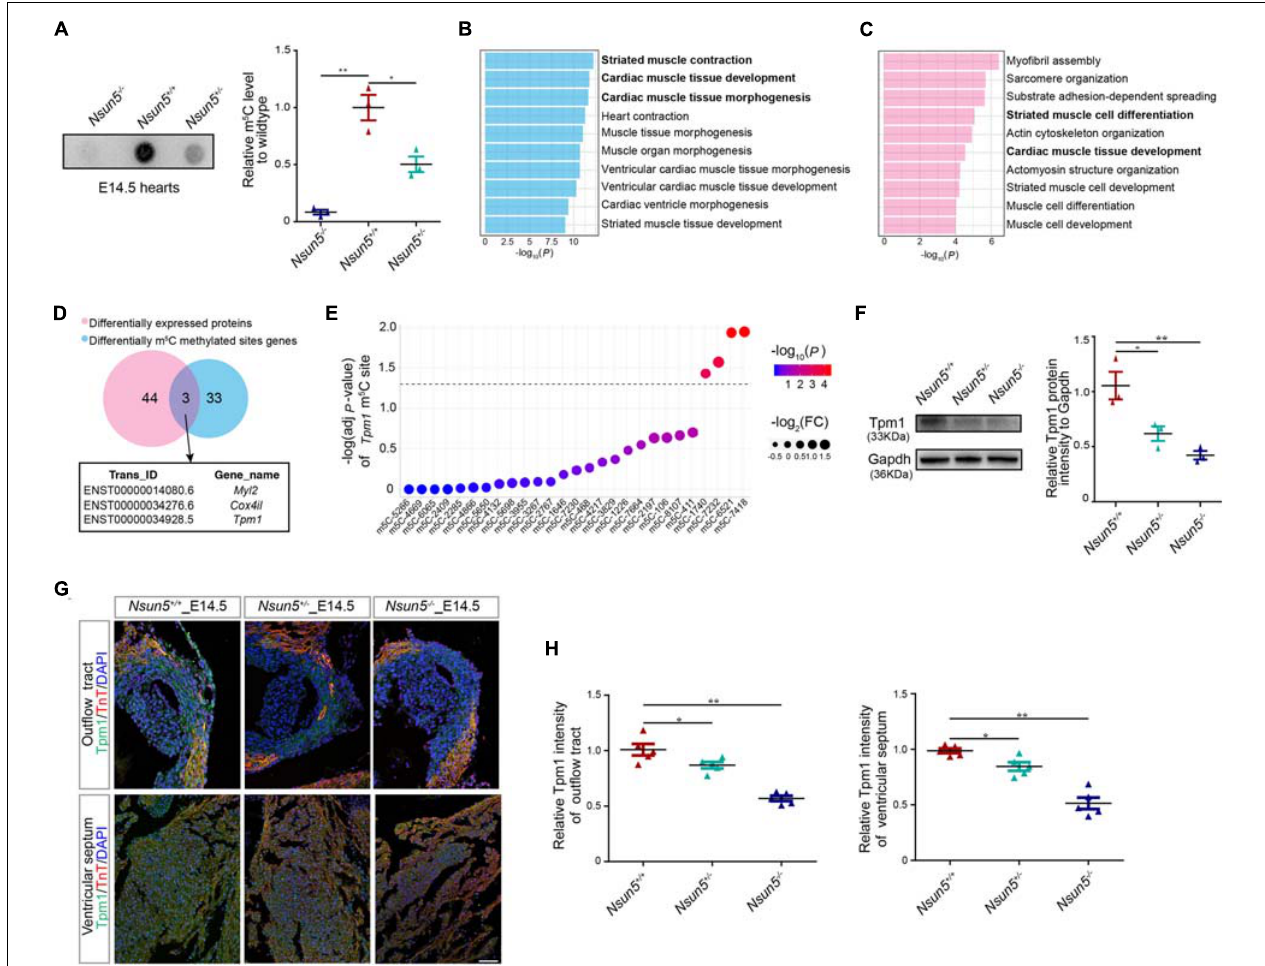
FIGURE 4 | Nsun5 regulated Tpm1 as a m 5 C methyltransferase. (A) The mRNAs isolated from E14.5 Nsun5 hearts were used in dot blot analyses with m 5 C antibody. n = 3/group. (B) GO-BP analysis for the DMSs genes in E14.5 Nsun5 + / + and Nsun5 - / - hearts. (C) GO-BP analysis for the differentially expressed proteins in E14.5 Nsun5 + / + and Nsun5 - / - hearts. (D) The overlap of identified DMSs genes and differentially expressed proteins by BS-seq and LC-MS/MS in Nsun5 - / - E14.5 hearts when compared with Nsun5 + / + controls. (E) DMSs in Tpm1 . Fold change of each DMS was indicated by the node size. P- value of each DMS was indicated by the bar color. The black horizontal line represents P = 0.05. (F) The protein expression of Tpm1 confirmed by western blot in E14.5 Nsun5 hearts. n = 3/group. (G,H) Quantitative results showed reduced Tpm1 intensity in Nsun5 deletion OFT aorta area and ventricular septum by immunofluorescence staining. The data was presented as the ratio of Tpm1 + area intensity/total area intensity. Cardiomyocytes were labeled by TnT. n = 5/group. Scale bar = 50 µ m. All the